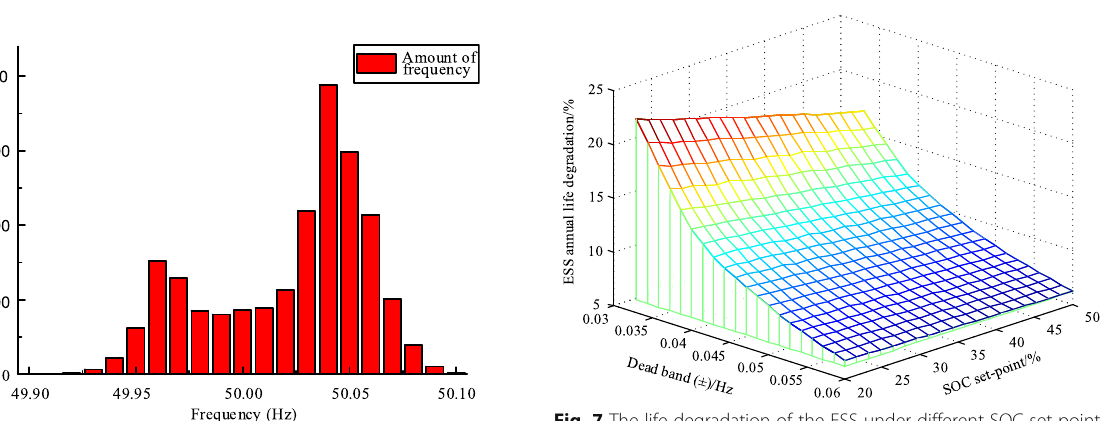
Fig. 5 The statistics histogram of frequency amount